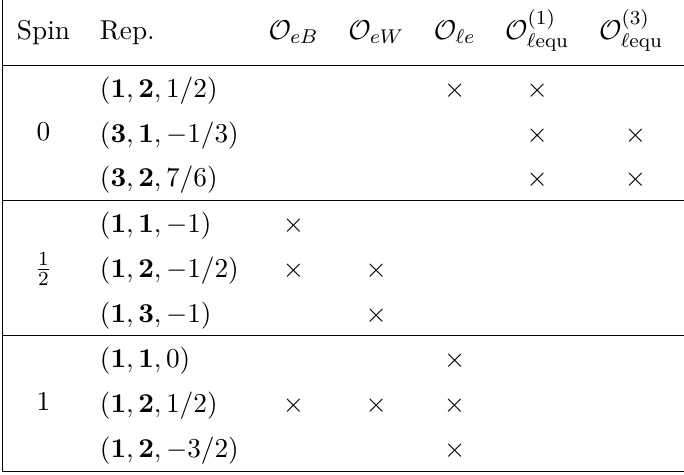
Table 2 . Scalar, fermion, and vector representations that generate SMEFT operators at tree level [100] relevant for ( g − 2)